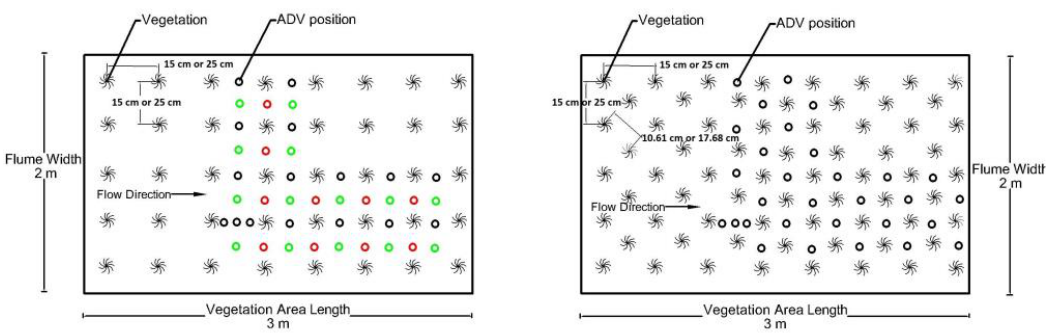
Figure 4. Schematic top view of a vegetative zone in the flume. Black pronged shape shows the positions of individual vegetation elements. Black circles are ADV measurement locations in the wake of each vegetation element. Red circles show the ADV location between two vegetation elements, and green circles show the ADV location in the center of four vegetation elements which have been placed in a square pattern. The spacing distance between adjacent vegetation elements is shown in the figure.